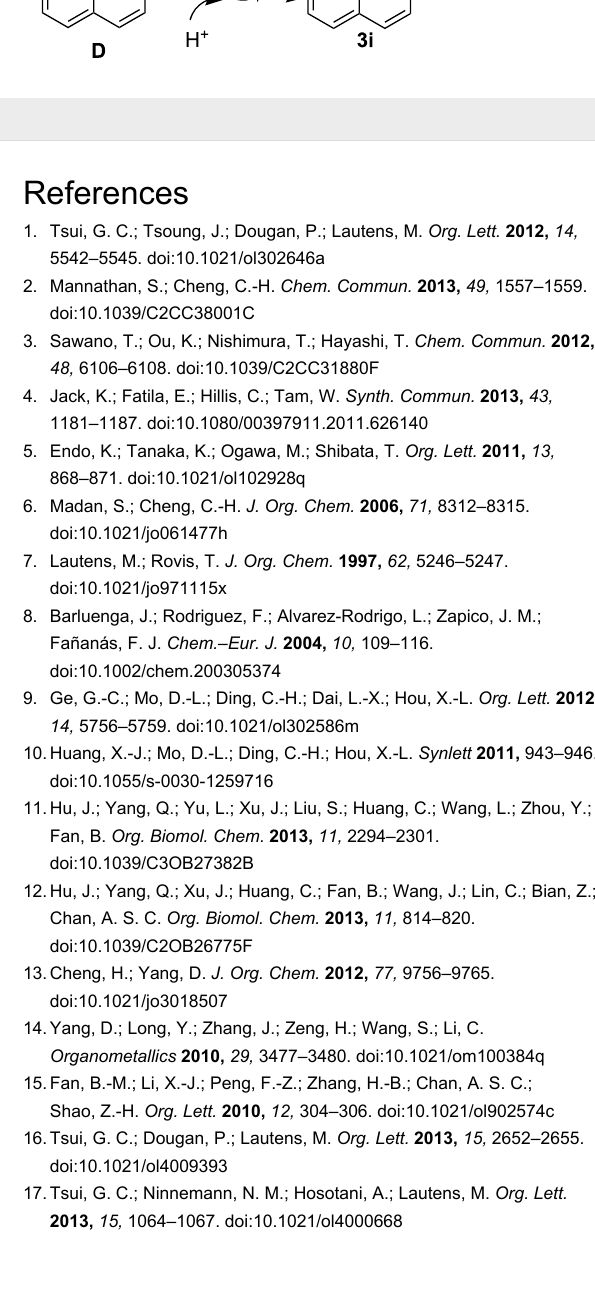
Scheme 4: The proposed mechanism for Au(I)-catalyzed reaction.